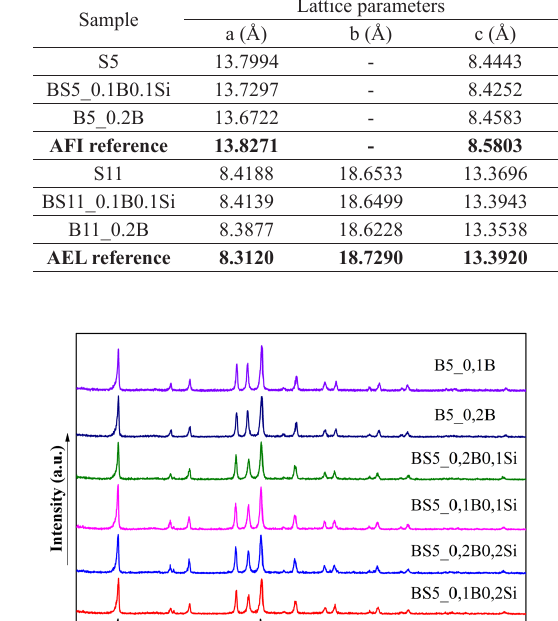
Table 2. Coding, composition and relative crystallinity of samples of the AEL structure. Sample